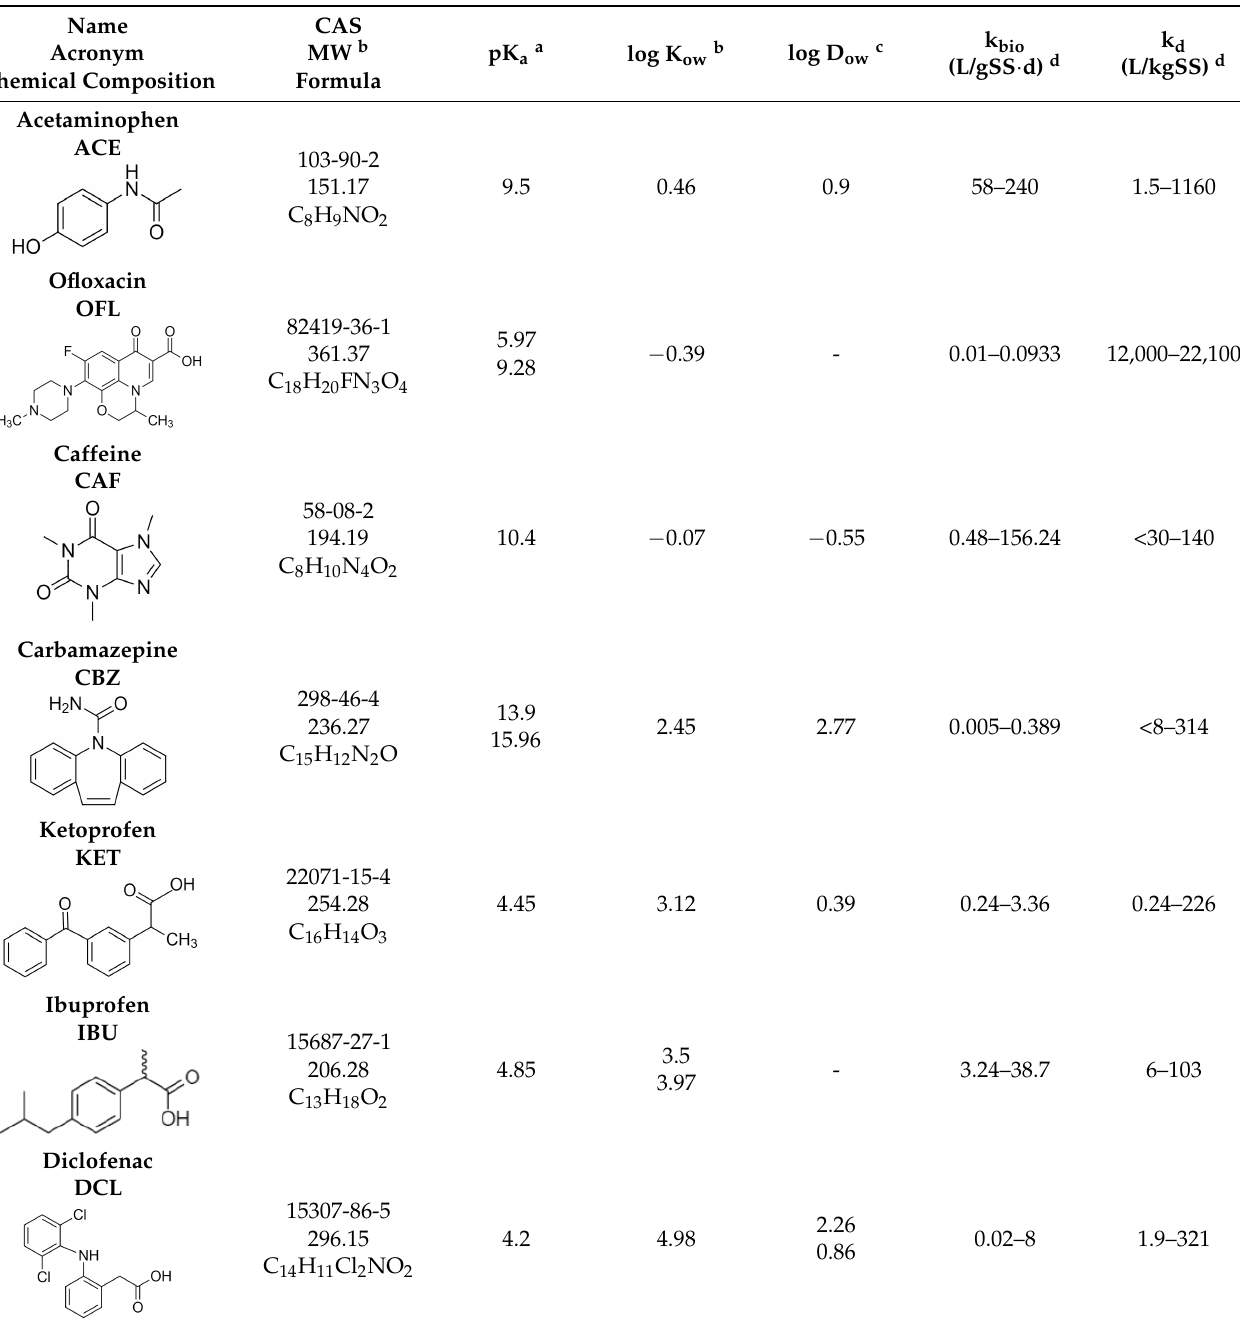
Table 2. Physicochemical properties of EOCs under review according to the references consulted on biological wastewater treatment processes a .